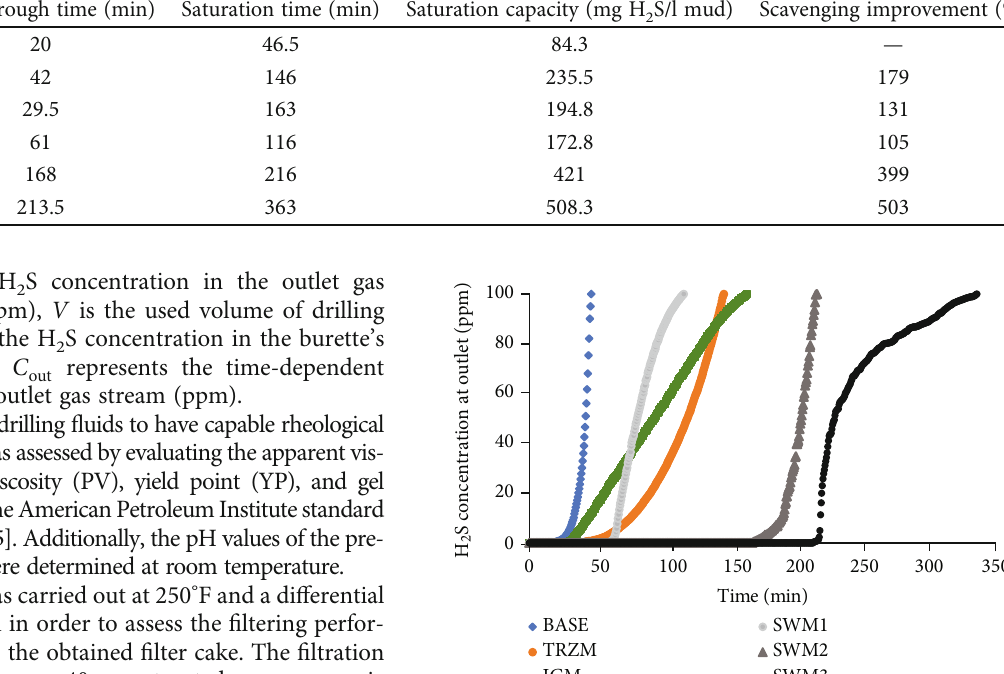
Table 3: Results of H